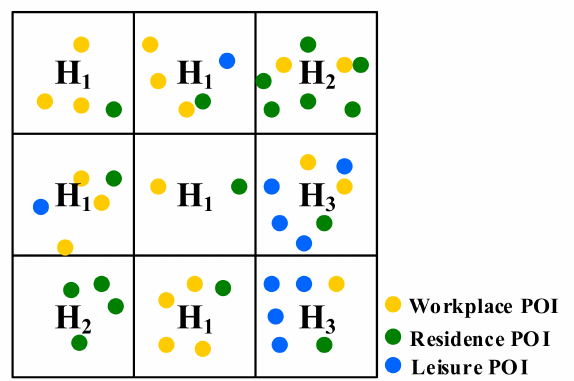
Figure 2. Illustration of POI semantics for functional regions.